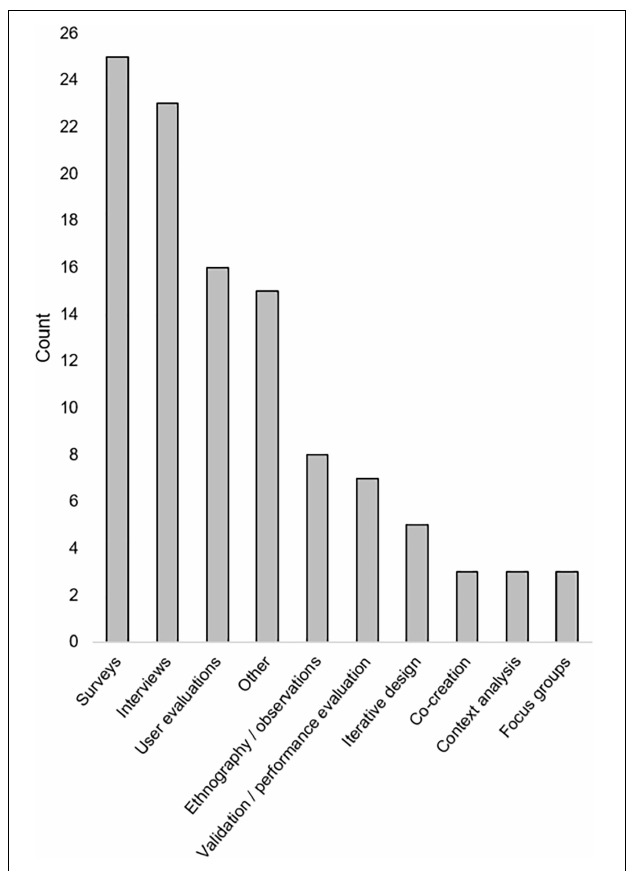
FIGURE 2 | Methods used within included articles and counts.